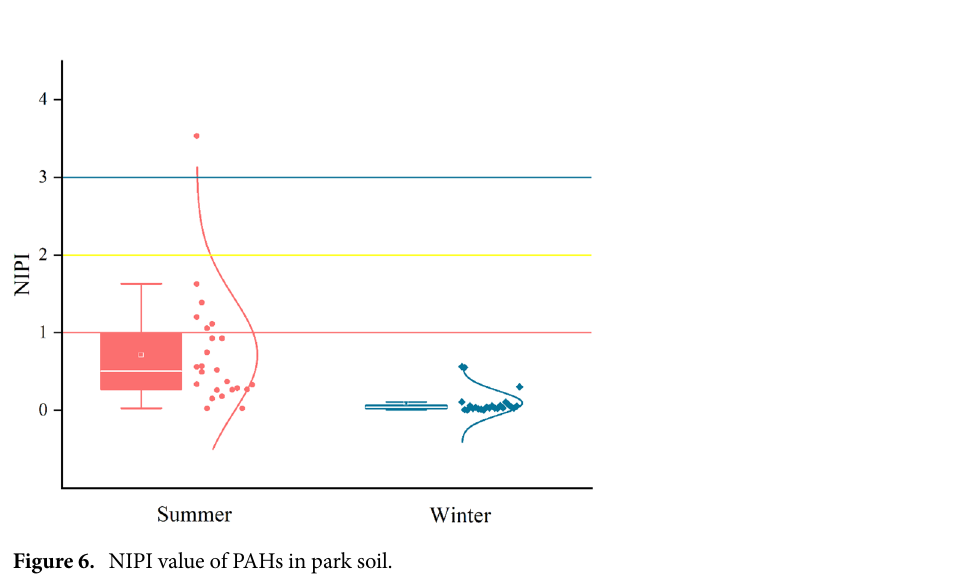
Figure 5. ILCRs value of PAHs in park soil.